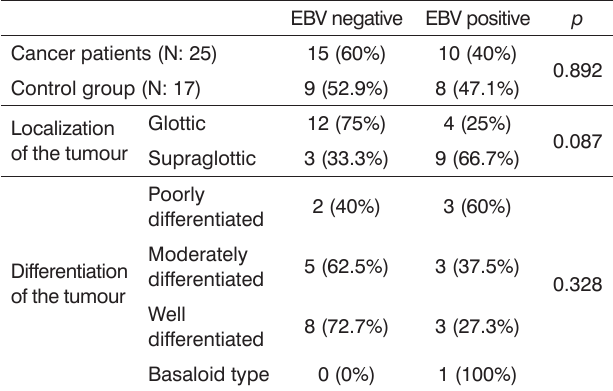
Table 1. EBV positivity rates of the patients and control group and the association between EBV positivity, localization and differentiation of the